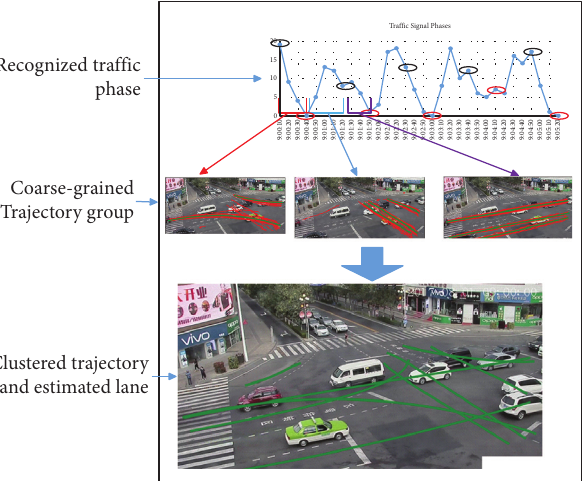
Figure 6: The process of lane